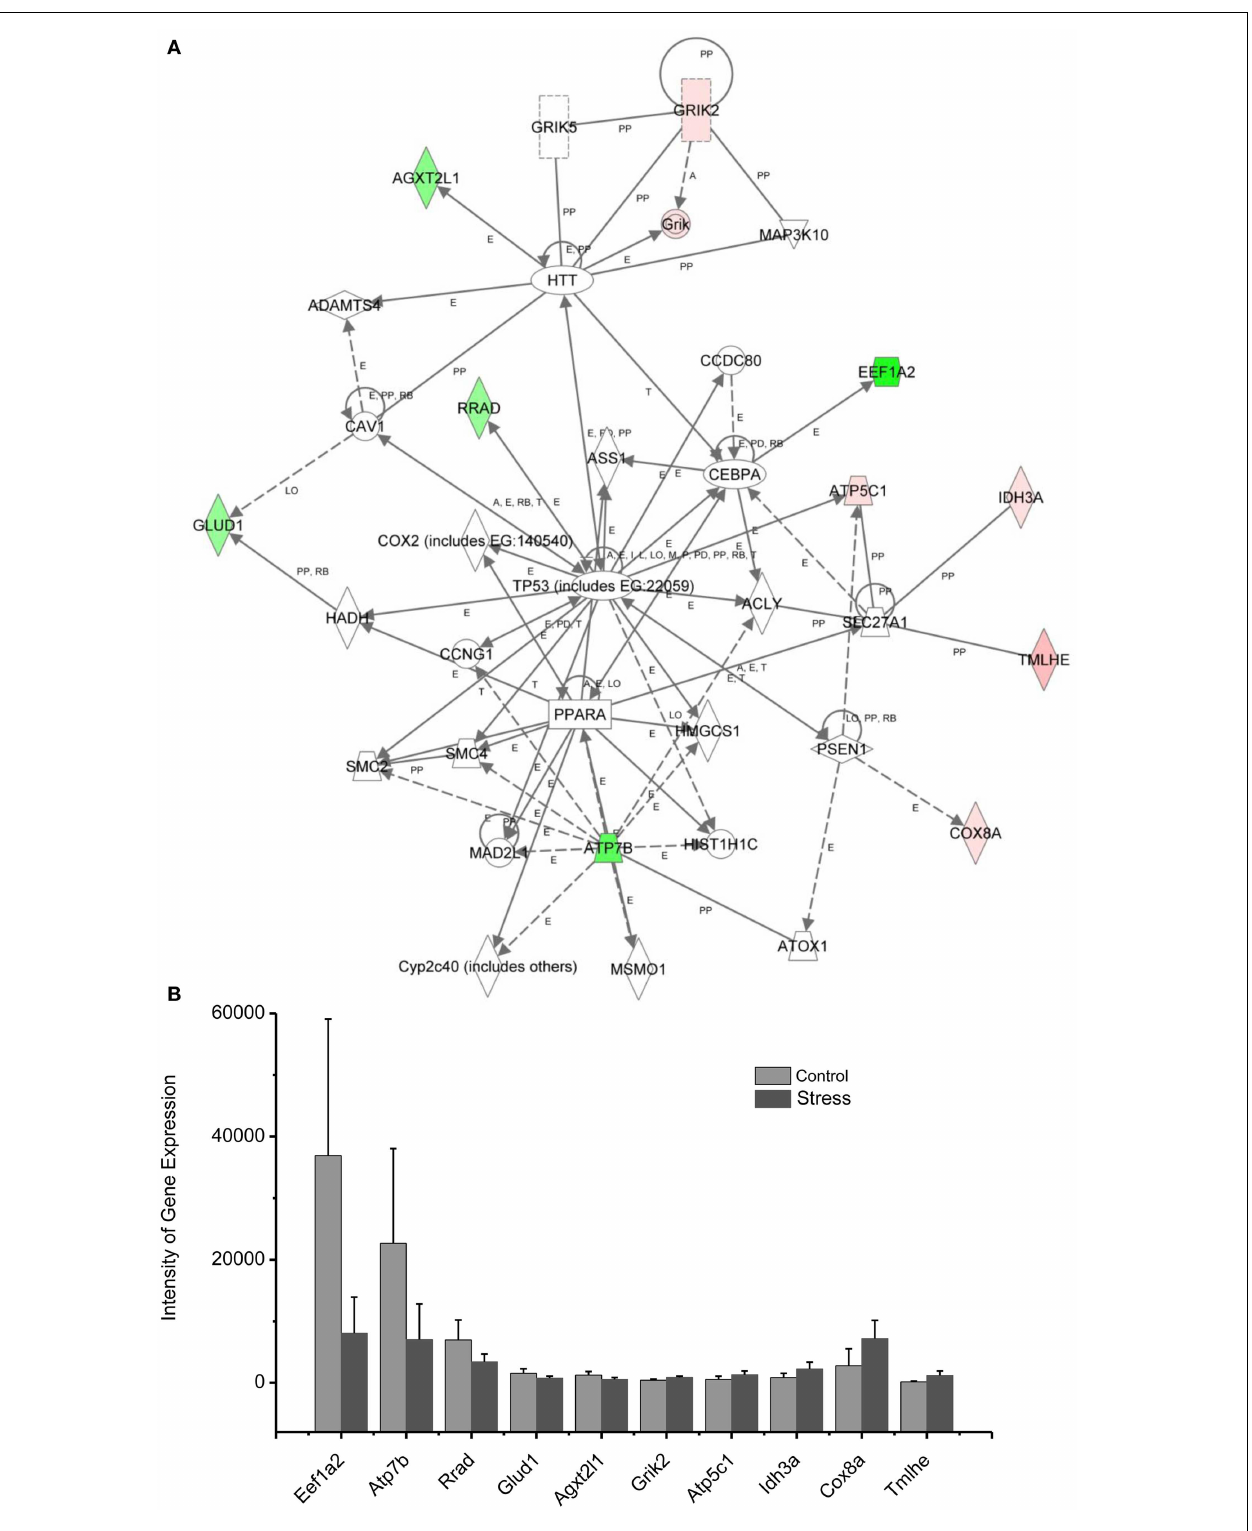
( p < 0.01, n = 10) in the network associated withTP53, PPARA, and HTT in the amygdala 14days after stress.The order is plotted according to fold change, from downregulated with lowest negative value to upregulated with highest positive